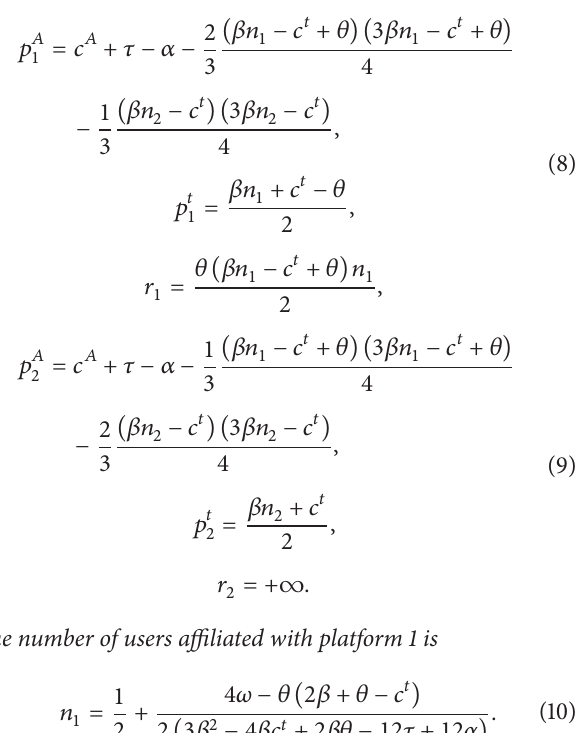
Note: the first and third rows and the first column of Table 1 list different combination of parameter region. The optimal price structure is summarized in the cells located in the second and fourth rows of Table